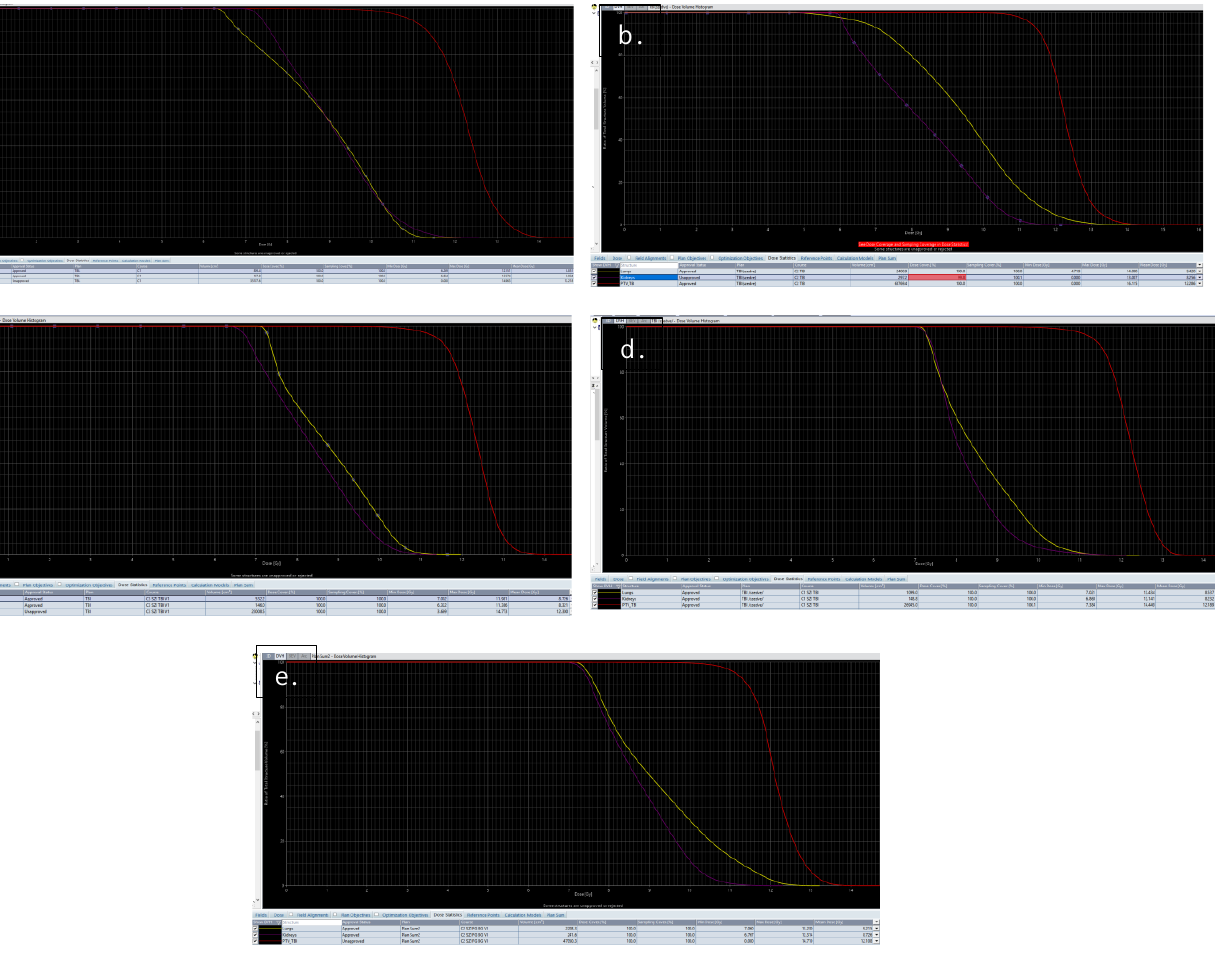
Figure 4. ( a – e ): Dose volume histograms of the patients: Patient-1 ( a ), Patient-2 ( b ), Patient-3 ( c ), Patient-4 ( d ), Patient-5 ( e ) (red color: planning target volume (PTV), organ at risks (OAR): yellow color: lungs, lilac color: